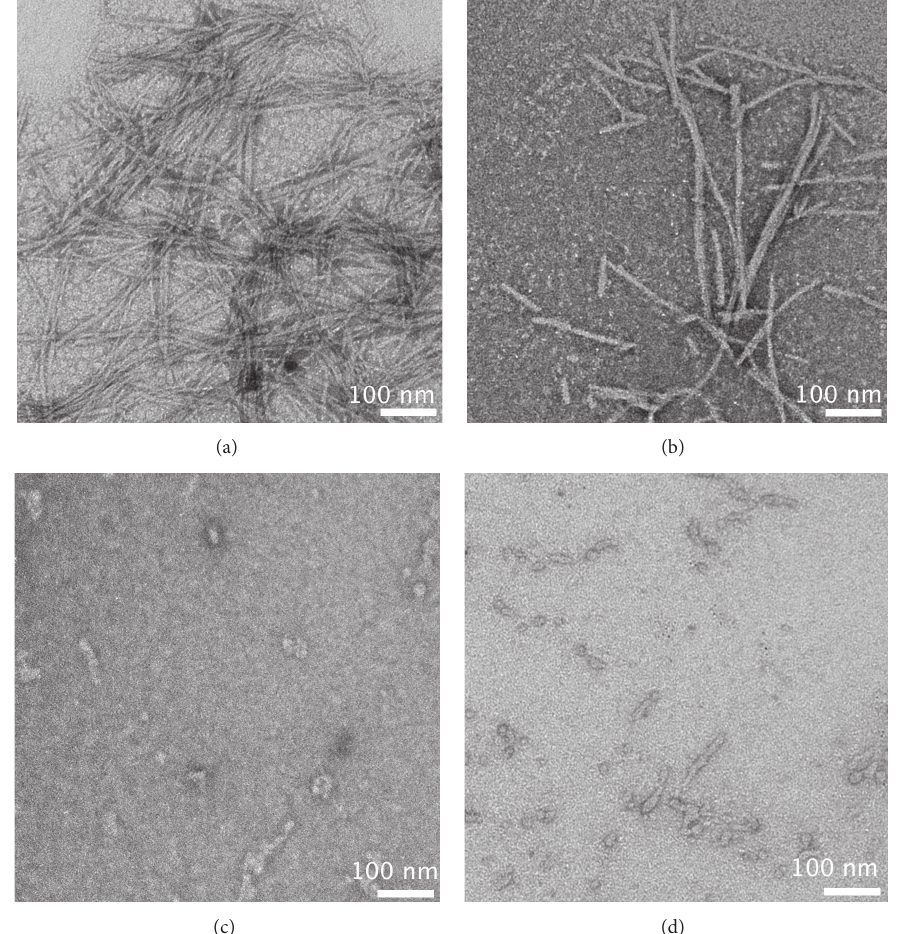
Figure 3: TEM images of aggregates formed by WT-amylin and charged variants. (a) WT amylin, (b) Arg-1, (c) Arg-2, and (d) Mem-T, after incubation for 2 days in 20 mM phosphate buffer, pH 7.4, at a temperature of 37 ∘ C. All peptide concentrations were 80 𝜇